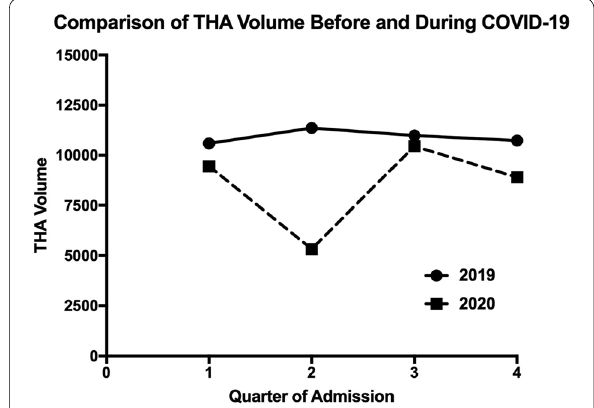
Fig. 1 Nationwide comparison of elective THA volume by quarter. through 2019Q4 ( p 0.984) . However, compared to 2019, elective = THA volumes minimally declined by 14.4% in 2020Q1, and drastically